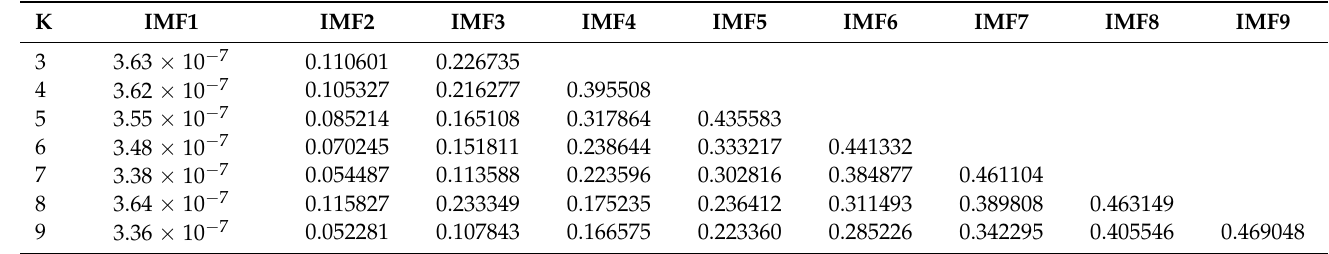
Table 5. Central frequency for the IMF components of the third set of PL.